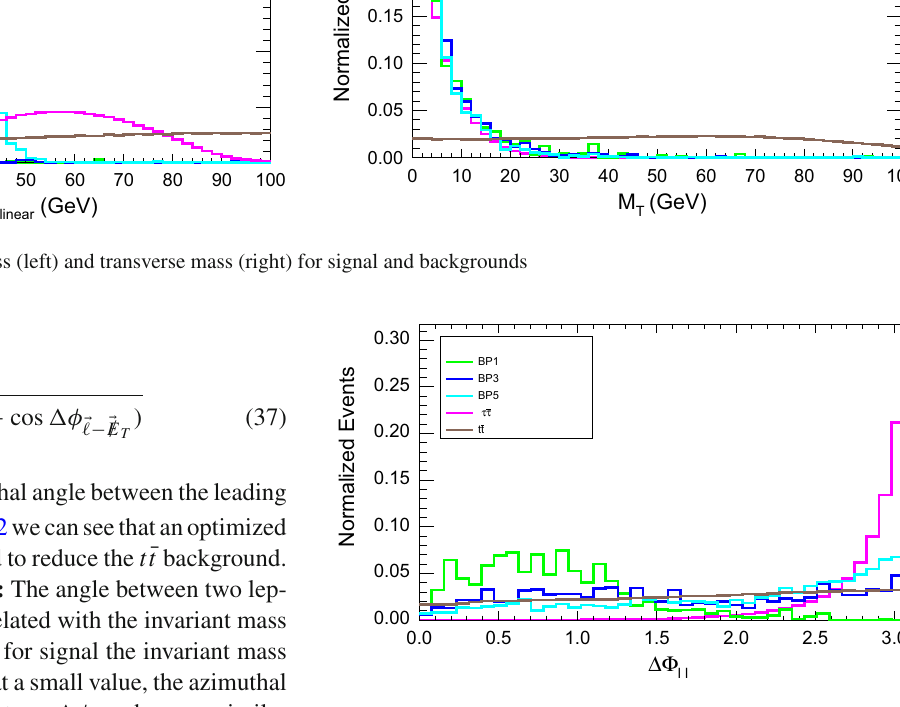
Fig. 8 Distribution of (cid:16)φ between two leptons for signal and back- grounds